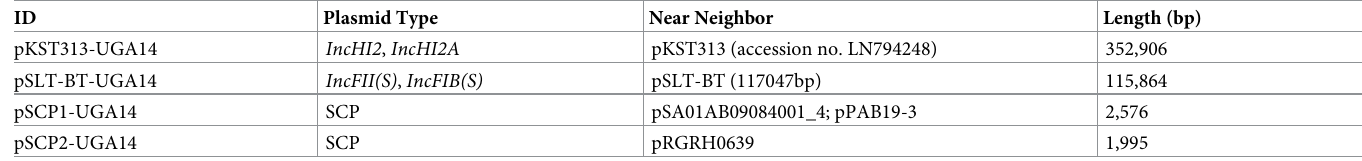
Table 4. UGA14 plasmid